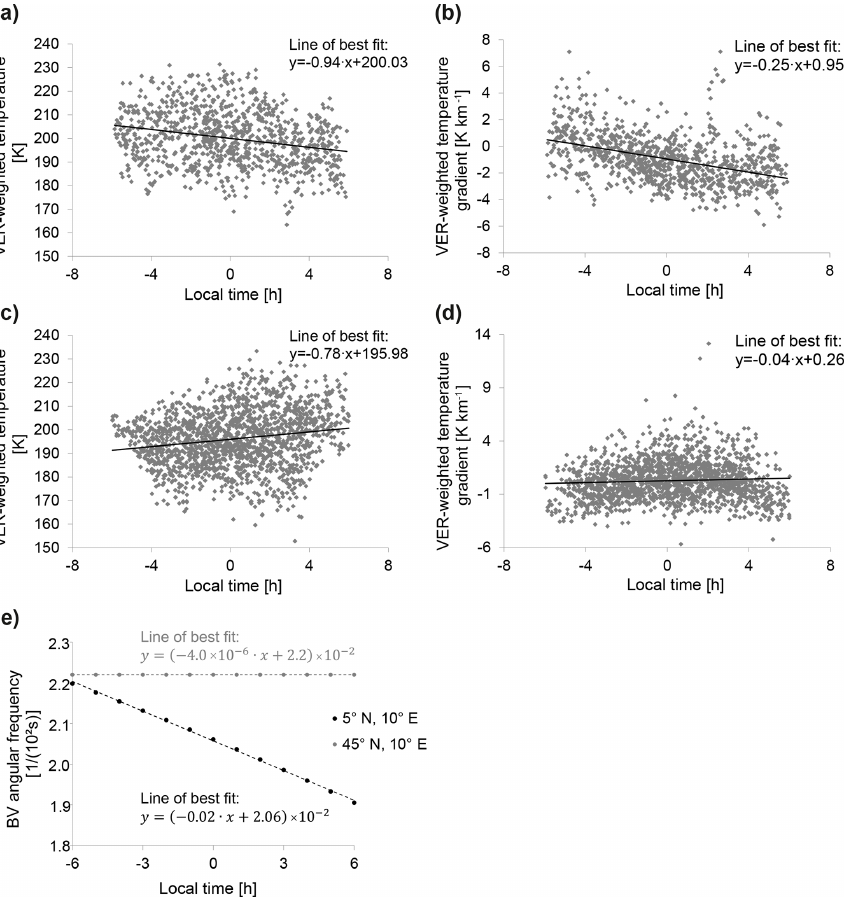
Figure 4. Temperature and vertical temperature gradient, both VER weighted, for 5 ◦ N (a, b) and 45 ◦ N (c, d) for the year 2002. The nomenclature concerning the local time agrees with the one explained in the caption of Fig. 3. Panel (e) shows the development of the BV frequency during the night for 5 ◦ N, 10 ◦ E (black), and 45 ◦ N, 10 ◦ E (grey), based on the linear approximation of temperature and its vertical